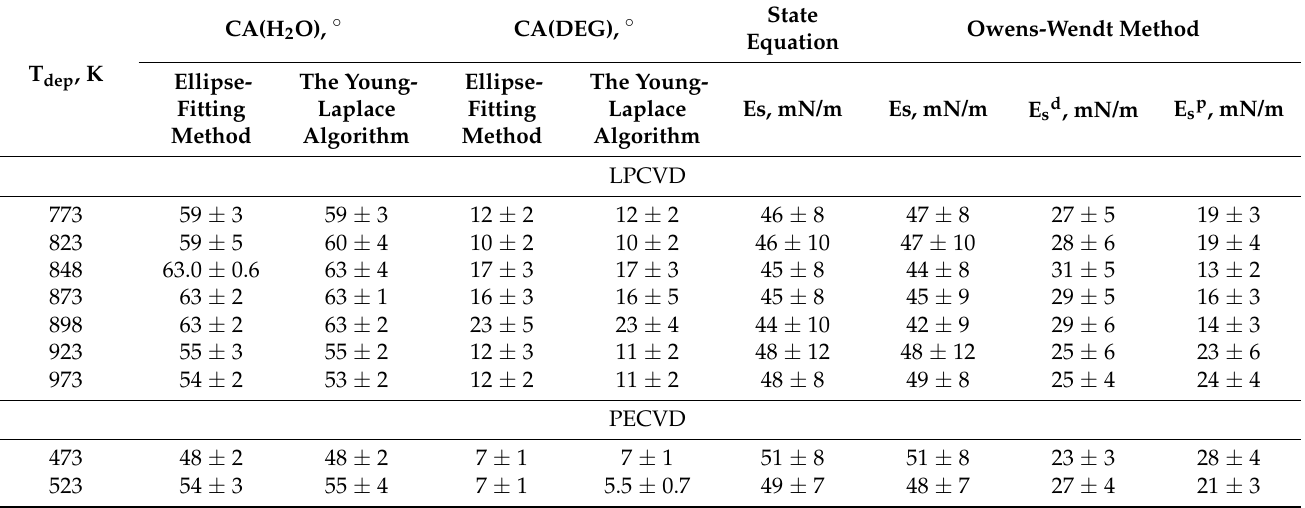
Table 6. Values of wetting contact angles with water and diethylene glycol and surface free energy for BC x N y